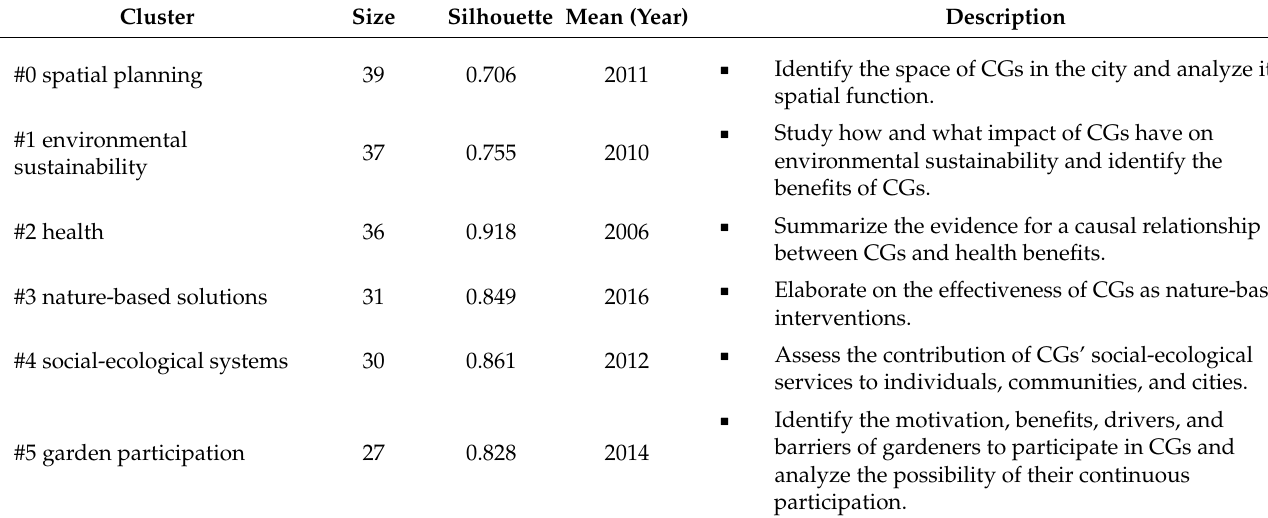
Table 7. Co-citation clusters